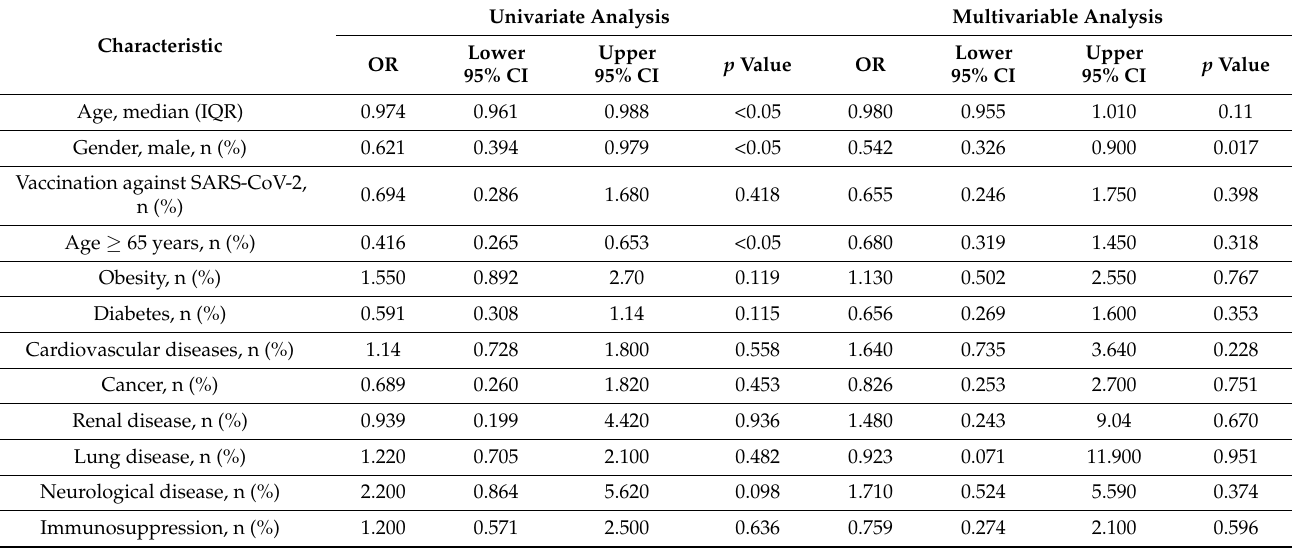
Table 4. Univariate and multivariable analysis for factors associated with AEs in patients who received